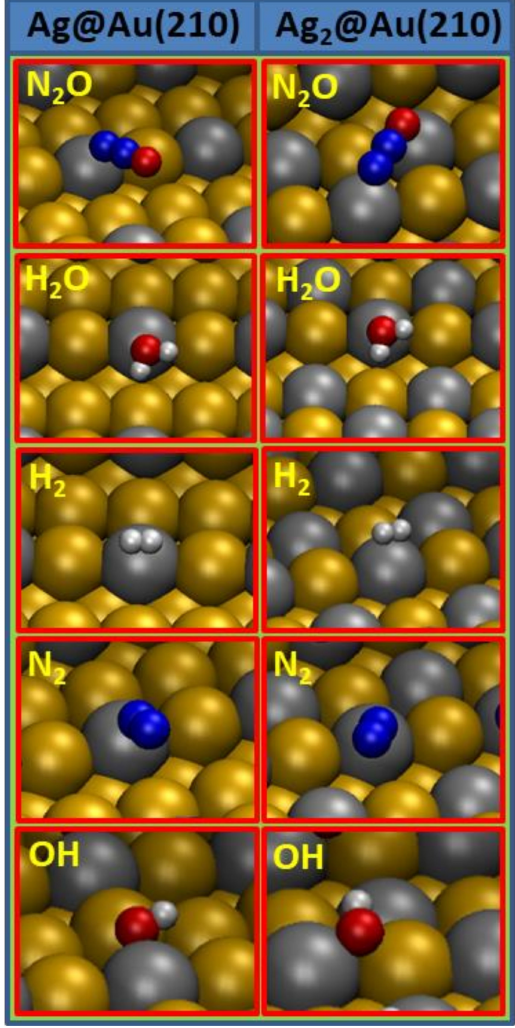
Figure 2. Most stable configurations for the adsorption of individual species on Ag@Au(210) and Ag 2 @Au(210) surfaces, which are involved in the N 2 O hydrogenation. Red color is used for oxygen, white for hydrogen, blue for nitrogen, grey for silver and ochre for gold